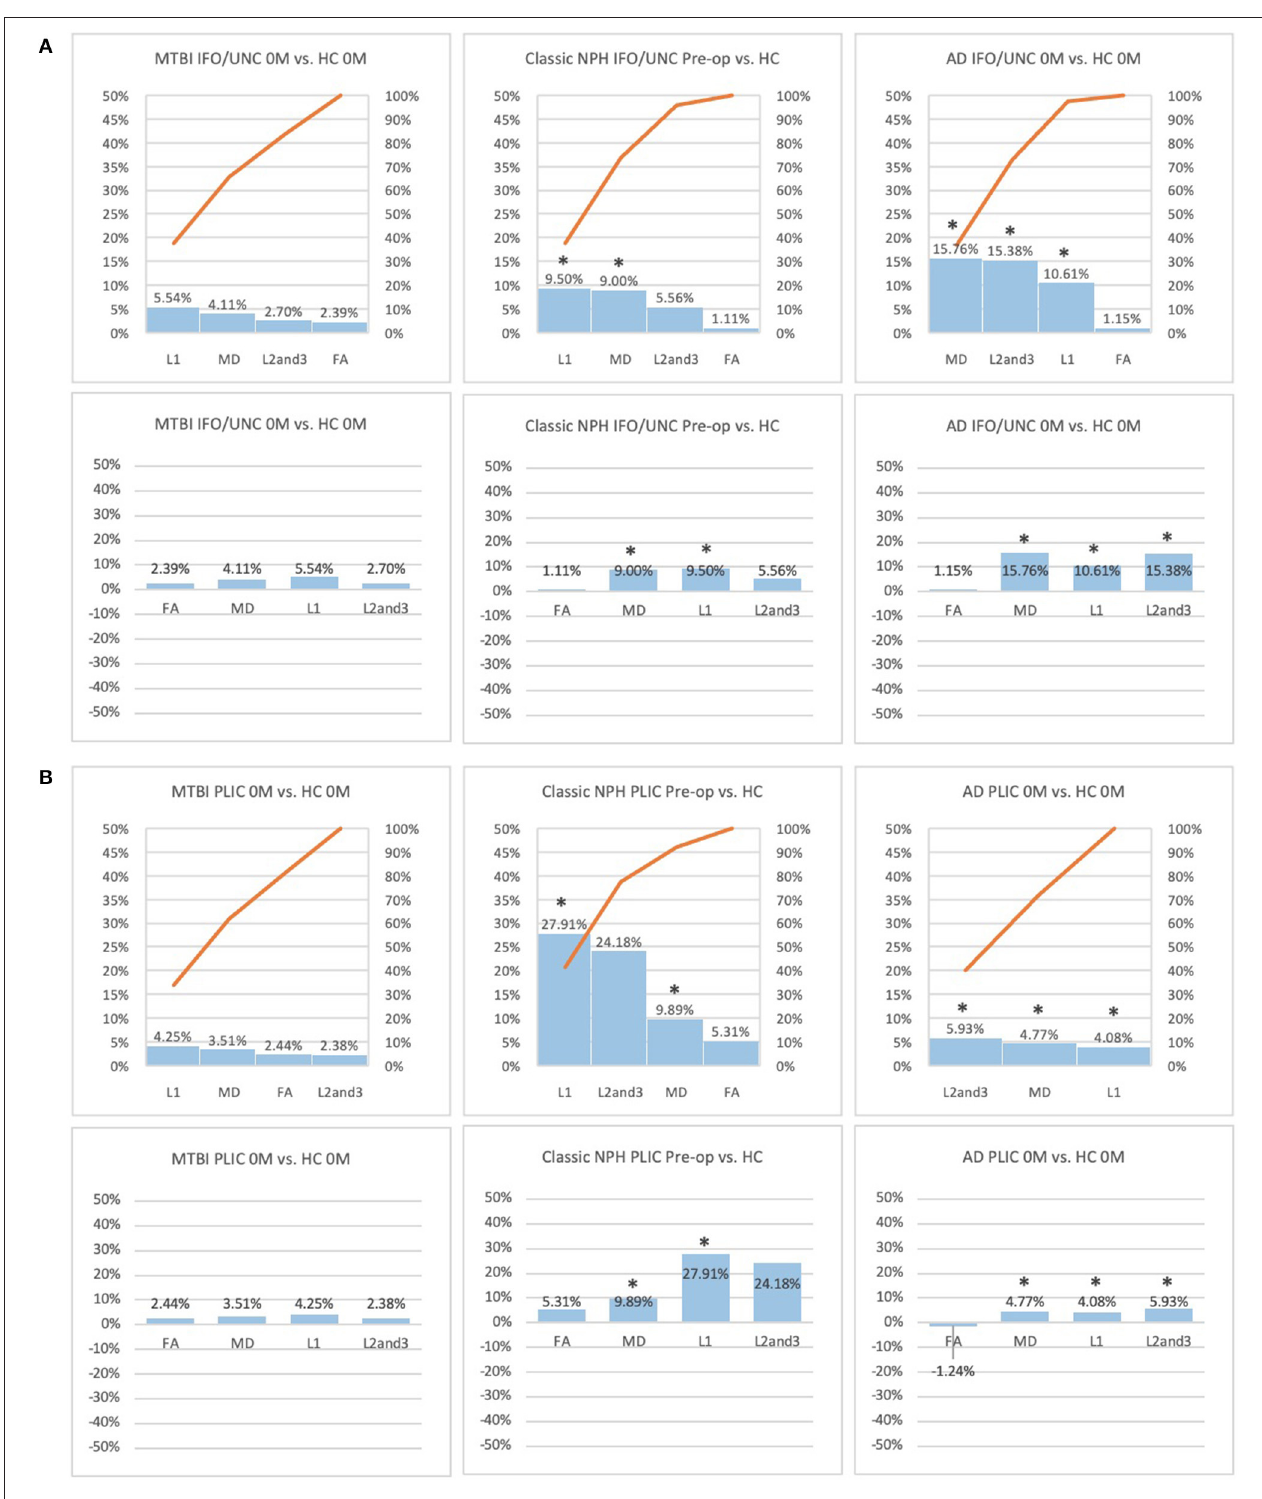
FIGURE 4 | (A) Fronto-temporal (IFO/UNC) and (B) remote functional (PLIC) ROI families at baseline. At baseline, percentage differences in DTI measures of clinical cohorts are compared against corresponding healthy controls, presented as Pareto graphs and bar charts. In Pareto graphs, positive values are automatically arranged sequentially, in order of highest to lowest magnitude of differences/changes. * indicates a significant difference between the clinical cohort and healthy controls at p < 0.05.